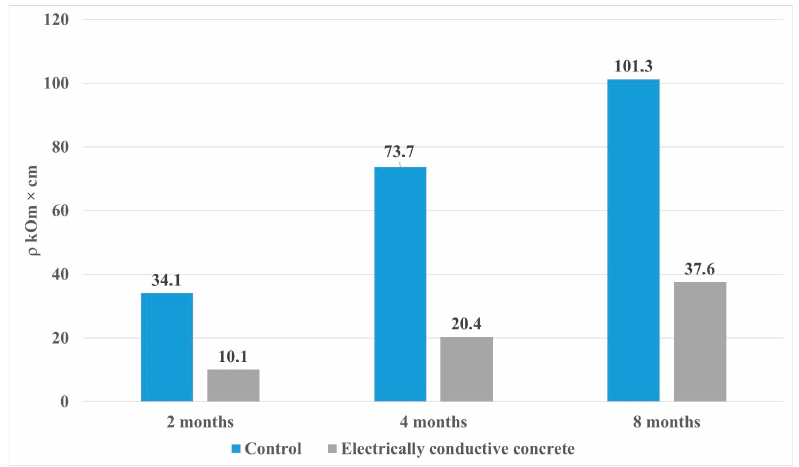
Figure 3. Effect of hydrosulfate corrosion on the electrical resistivity of samples.